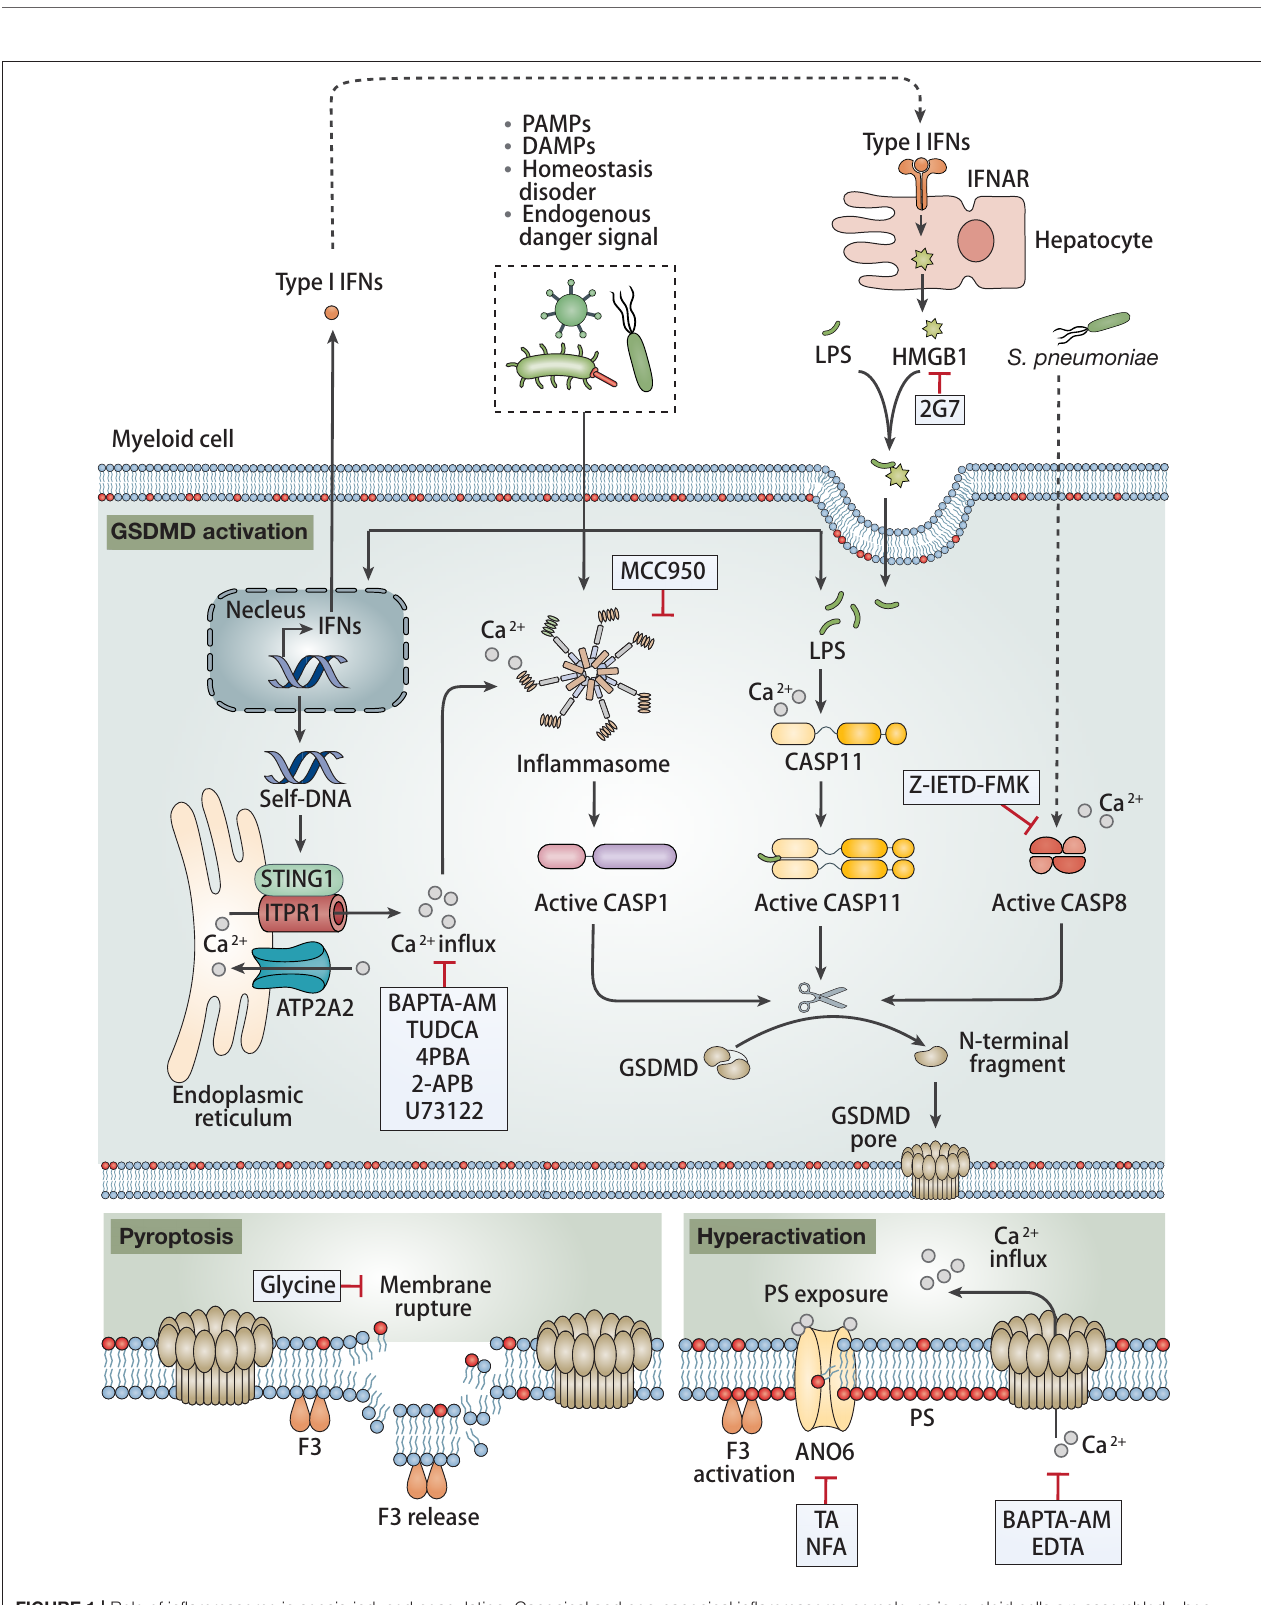
FIGURE 1 | Role of inflammasome in sepsis-induced coagulation. Canonical and non-canonical inflammasome complexes in myeloid cells are assembled when pattern recognition receptors (PRRs) sense pathogen-associated molecular patterns (PAMPs), damage-associated molecular patterns (DAMPs), altered